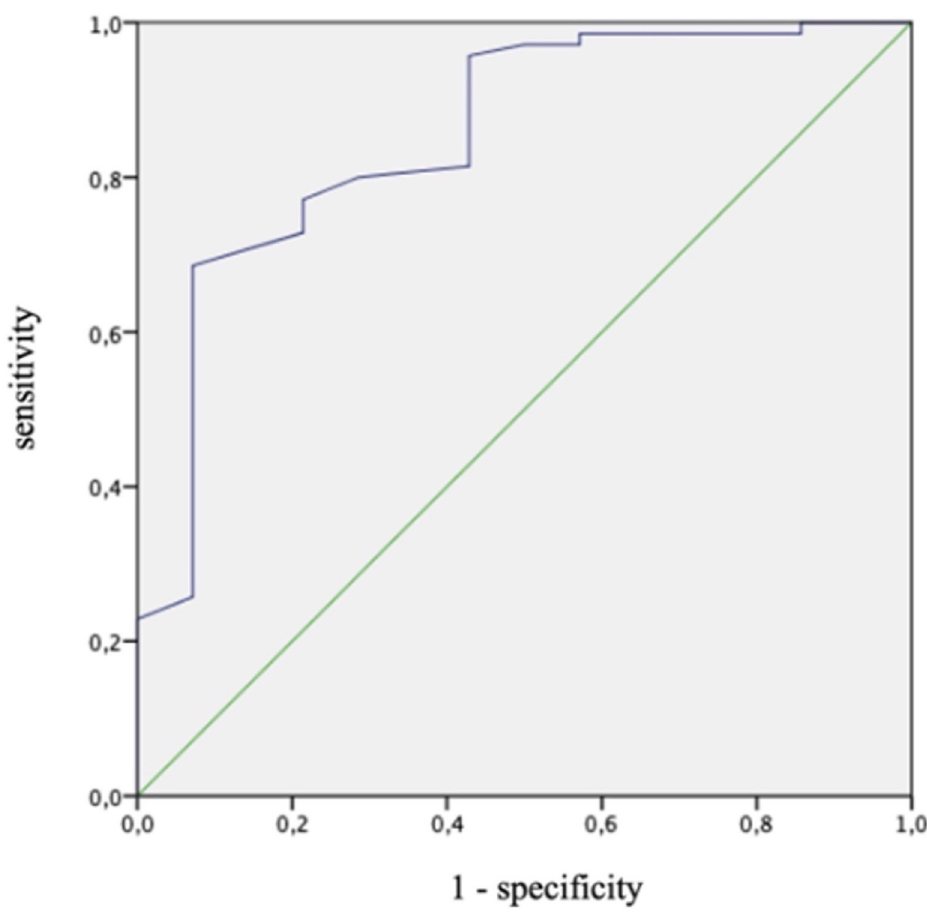
Fig 2. Receiver operating characteristic curve for the detection of pulmonary hypertension (mPAP � 25mmHg) through PA:A. mPAP = mean pulmonary artery pressure. PA:A = pulmonary artery to ascending aorta ratio.